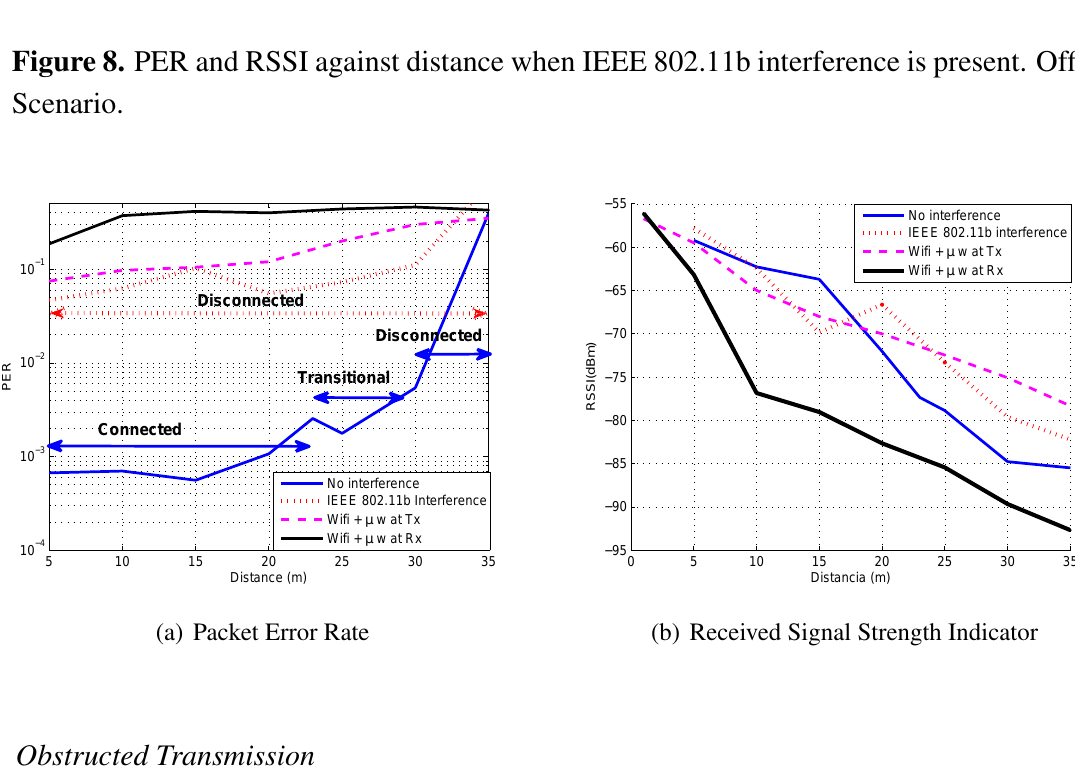
Figure 8. PER and RSSI against distance when IEEE 802.11b interference is present.